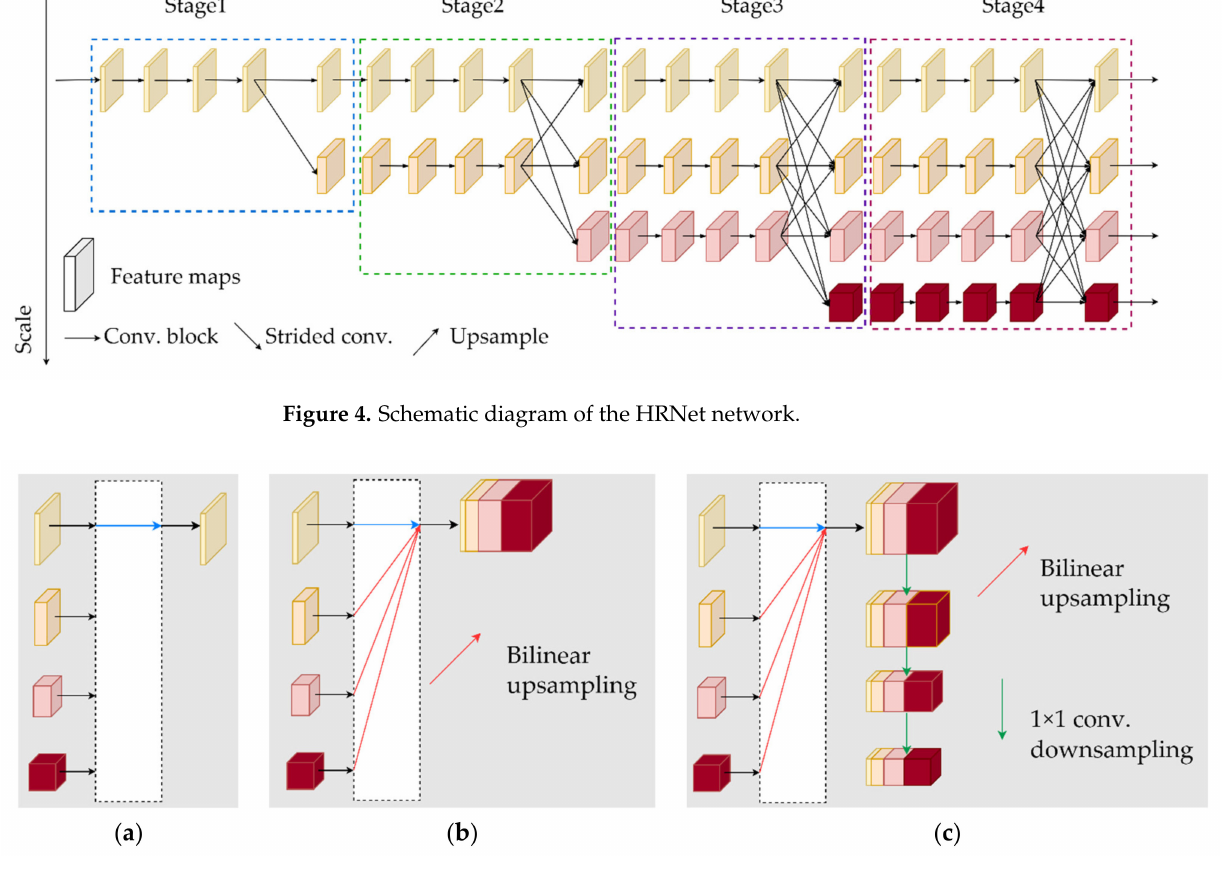
Figure 5. Output representation of different versions of HRNet: ( a ) output representation of HRNetV1; ( b ) output representation of HRNetV2; ( c ) output representation of